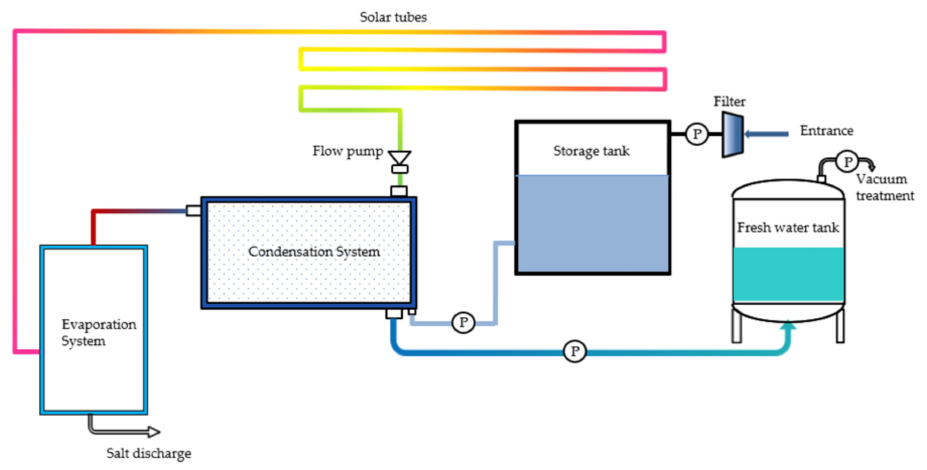
Figure 3. Schematic diagram of the proposed system.